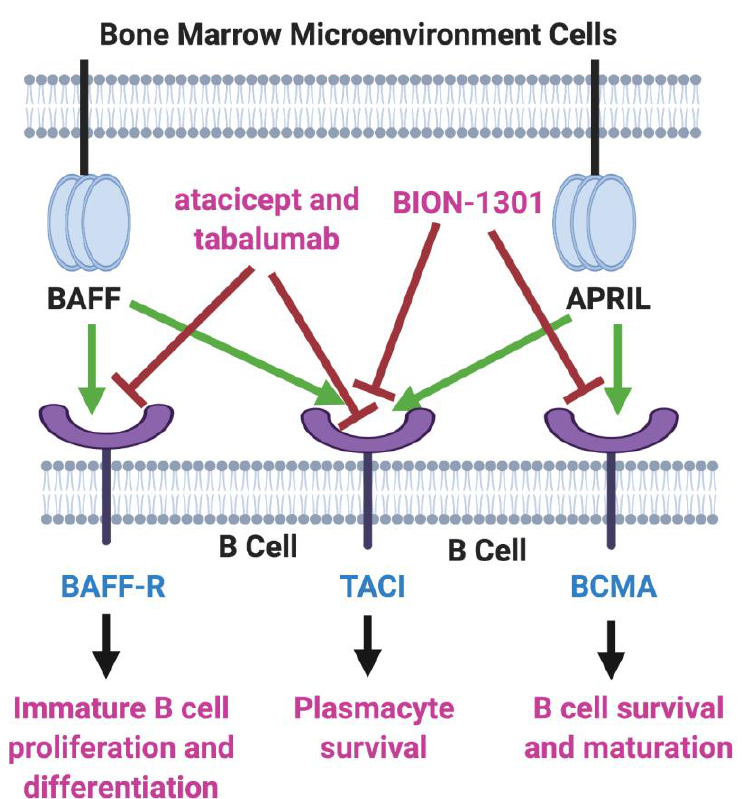
Figure 1. BAFF / APRIL / BCMA Axis. Tumor necrosis factor (TNF) family members BAFF (B-cell Figure 1. BAFF/APRIL/BCMA Axis. Tumor necrosis factor (TNF) family members BAFF (B-cell activating factor) and APRIL (a proliferation-inducing ligand) are cytokines secreted in the bone marrow microenvironment that play key roles in B cell development, as well as in supporting the viability and proliferation of plasma cells in multiple myeloma. Both BAFF and APRIL serve as ligands for two receptors on the myeloma cell surface—transmembrane activator and calcium modulator and cyclophilin ligand interactor (TACI) and B-cell maturation antigen (BCMA). BAFF also binds to BAFF-R, another myeloma cell receptor. The receptor blockers shown, atacicept, tabalumab, and BION-1301, have been studied in MM patients but have failed to provide evidence of e ffi cacy. On the other hand, inhibitors of BCMA have demonstrated great potential in the therapy of MM. Created with